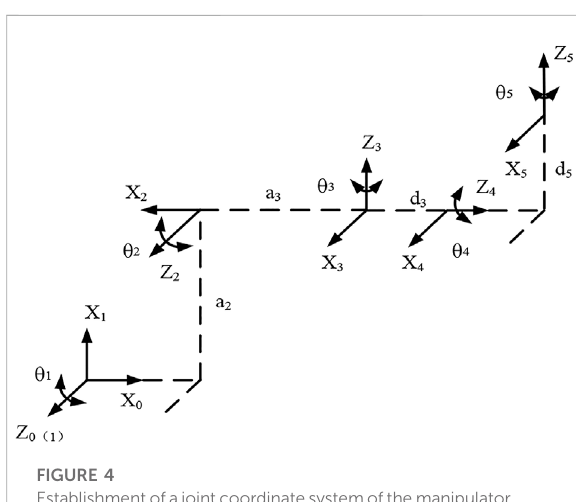
FIGURE 4 Establishmentofajointcoordinatesystemofthemanipulator by using the D − H